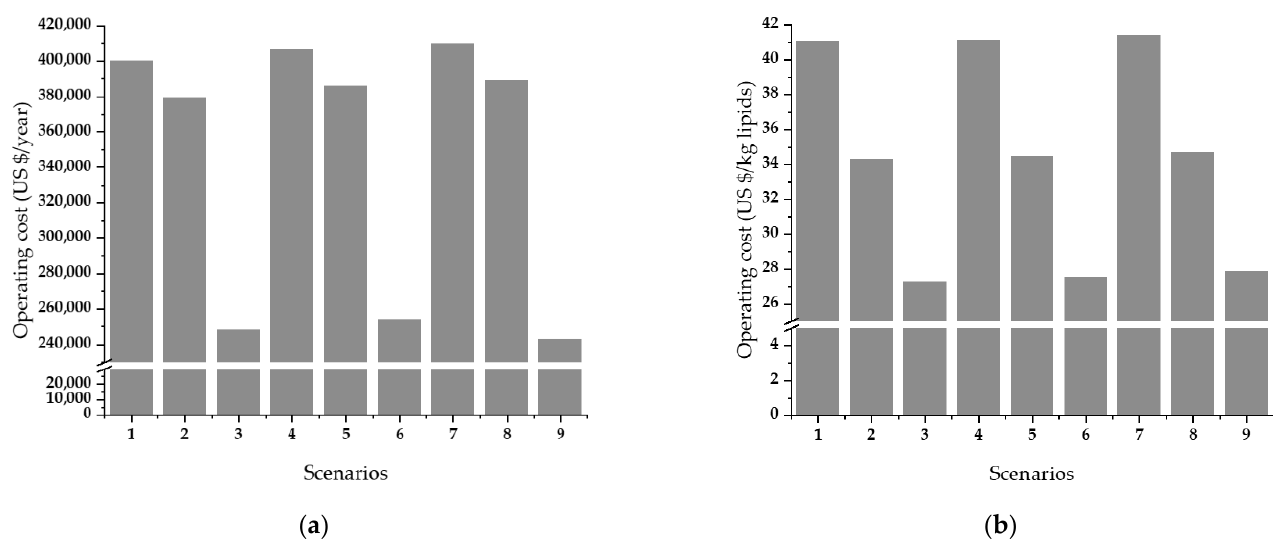
Figure 7. Operating cost in the scenarios analyzed for lipid production: ( a ) Total operating cost per year; ( b ) total operating cost per kg of lipids produced. year; ( b ) total operating cost per kg of lipids